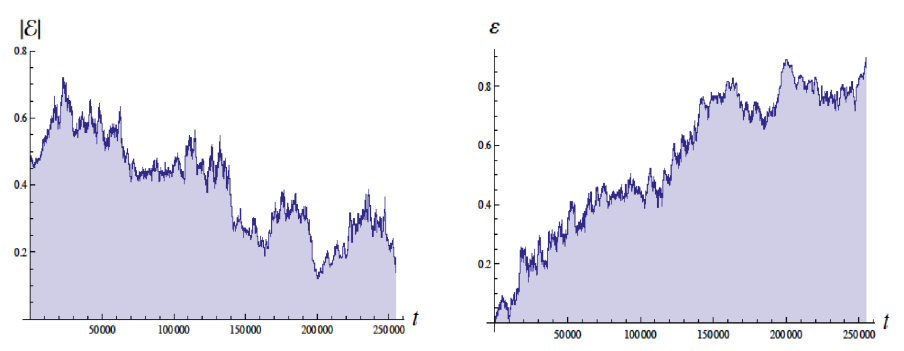
Figure 6. Plots of the energy E (left side) and the eccentricity (cid:101) (right side) as a function of time for Z = 1 with a fixed cutoff exposing the trend towards ionization at E = 0, (cid:101) = 1. The time window in 45 times shorter than in Figures 4 and 5. Figure from [4] with